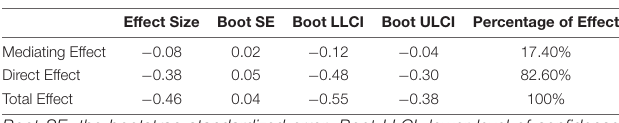
TABLE 6 | Analysis of mediating effect in model 2.